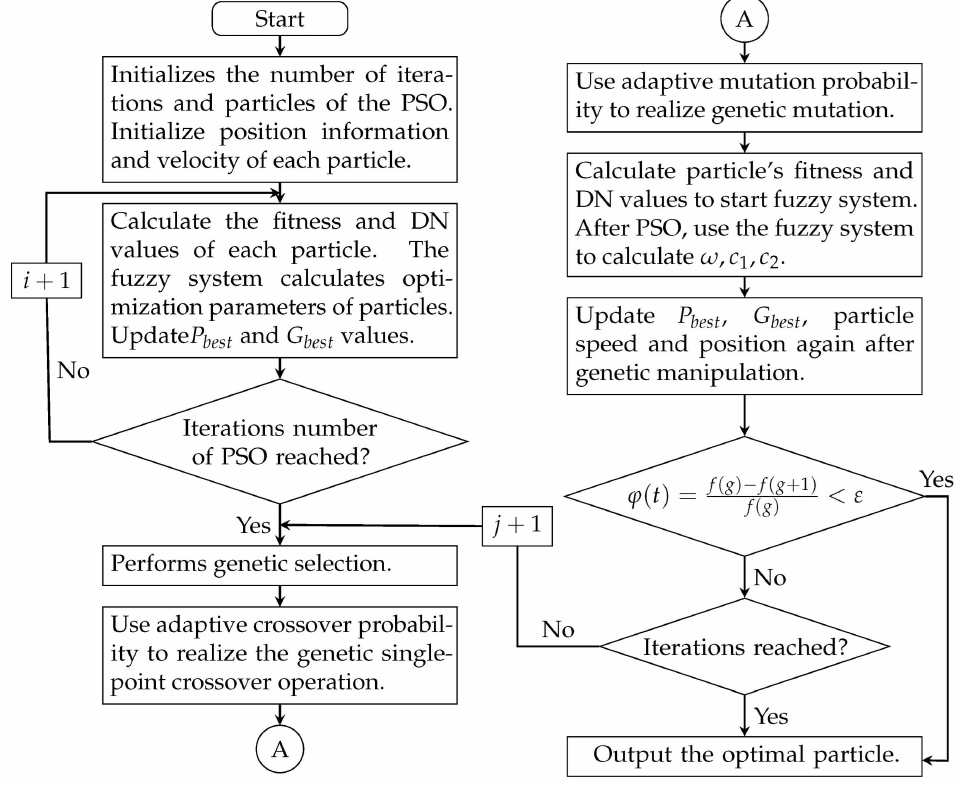
Figure 1. The flow of the novel FPSO-GAK clustering